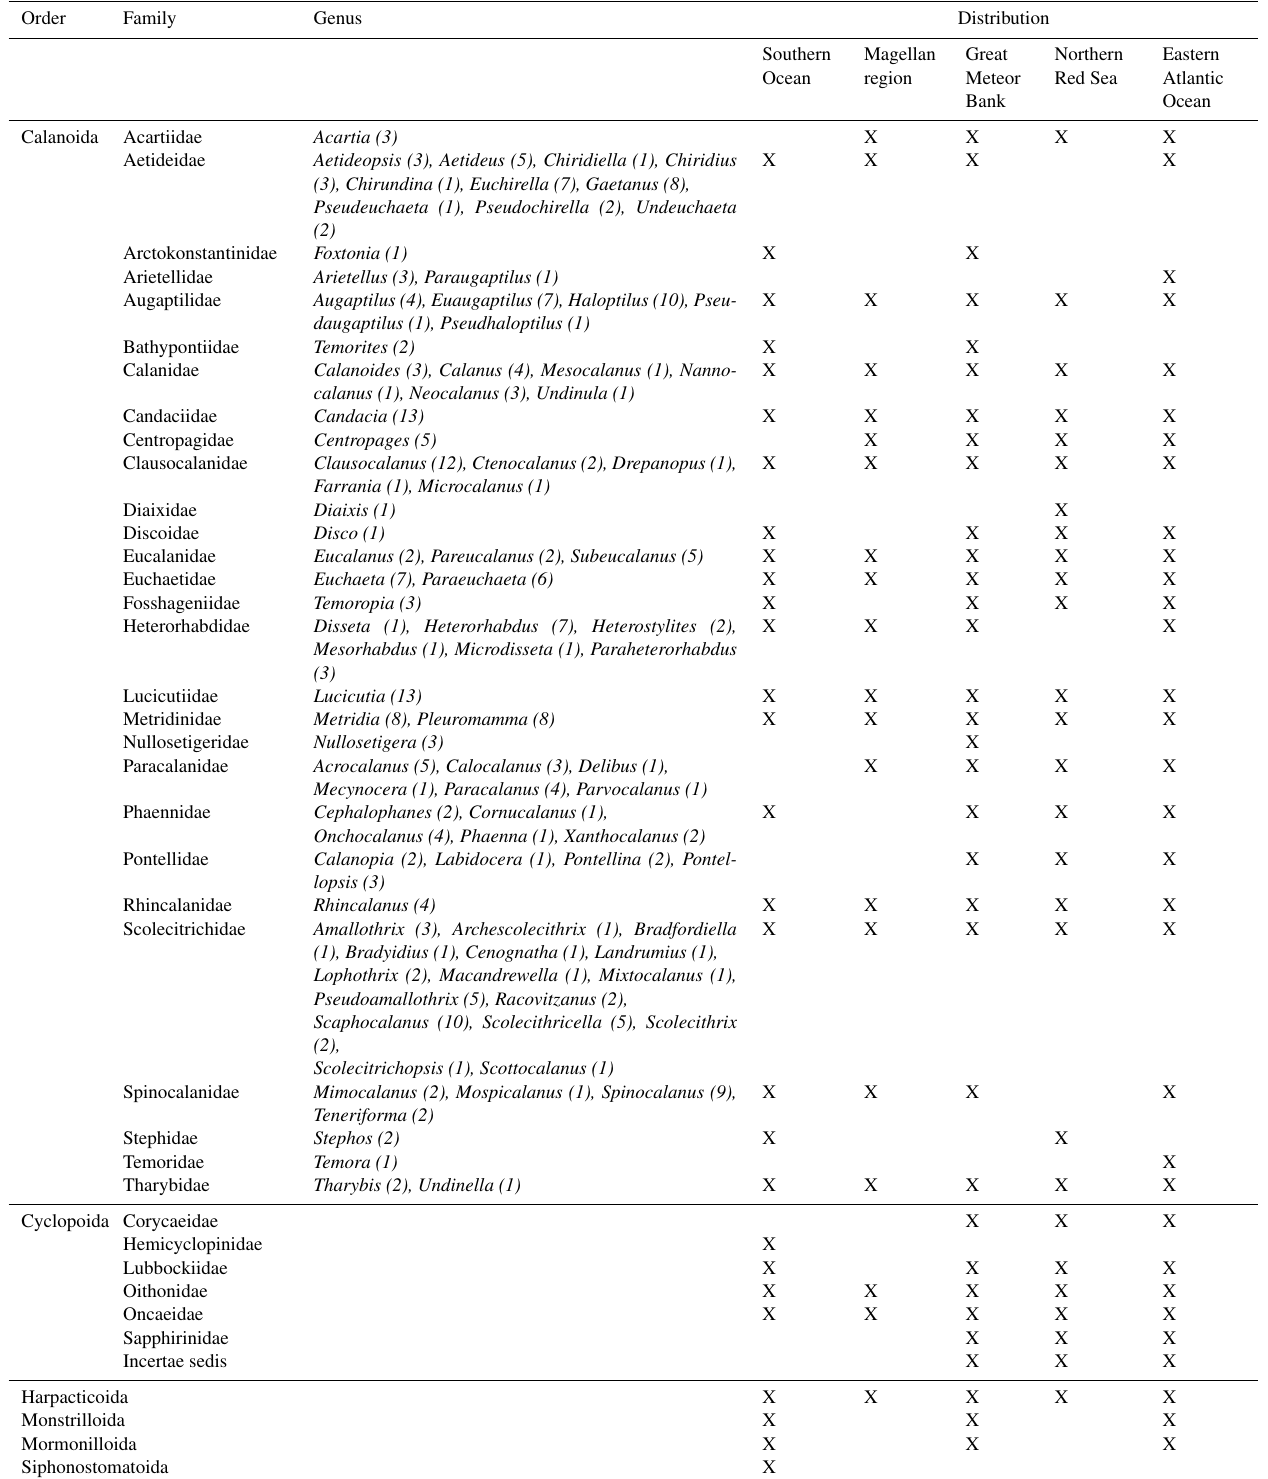
Table 2. List of calanoid copepod families and genera, cyclopoid families, and other orders compiled in this data collection. The number of species for each genus is written in parentheses. The presence of the calanoid and cyclopoid families and other copepod orders in the five different regions is marked (X). For a complete overview of all species see the “Copepod species list” at https://doi.org/10.1594/PANGAEA.